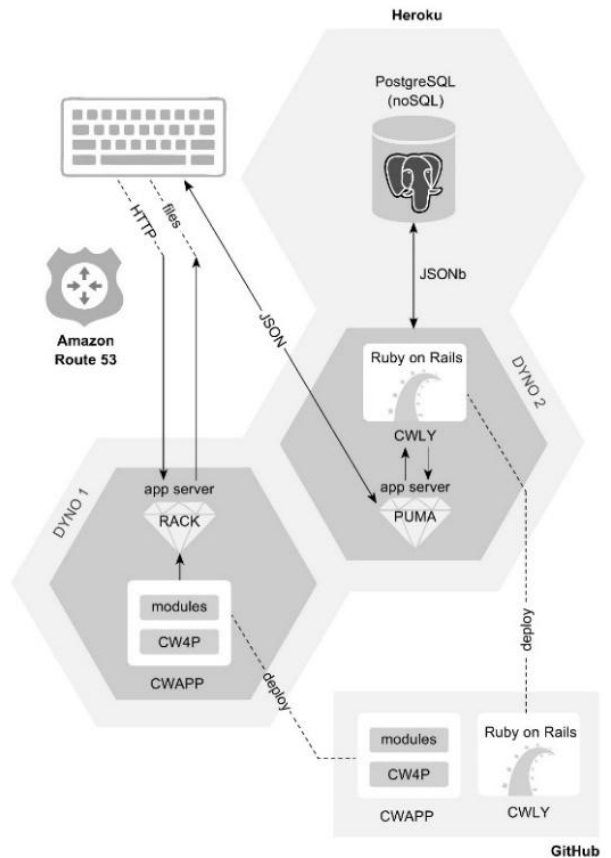
Figure 1. System Architecture. The short URL is handled by Amazon Route 53 service, which directs to the CWAPP application. CWAPP provides necessary modules on demand and CWLY allows access to a database, in order to store or retrieve user created structures. Both applications are hosted on virtualized servers at Heroku. GitHub holds the latest version of the code, which is automatically deployed to Heroku at every update. Source: adapted from [10].